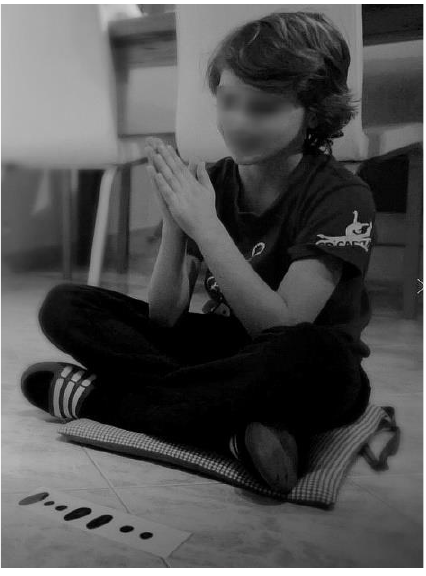
Figure 5. A clip from a video of a ten-year-old pupil performing a rhythm task.